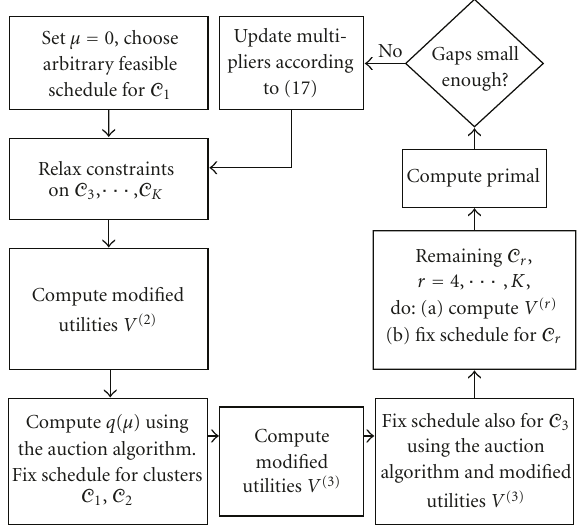
Figure 2: Flowchart of the proposed